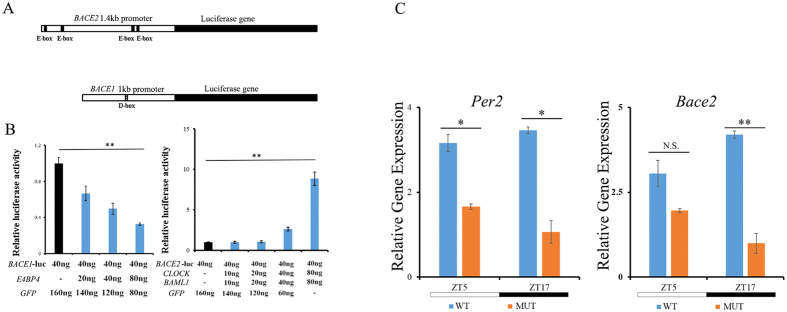
Expression of the BACE genes is controlled by the clock.(A) Schematic plot of the promoters of the BACE genes, including four possible E-boxes located in the 1.4-kb BACE2 promoter and one D-box located in the 1-kb BACE1 promoter. (B) Left pane: transfection of E4BP4 inhibited the transcription of Bace1 in a dose-dependent manner. Right pane: The CLOCK:BMAL1 complex activated the expression of Bace2 in a dose-dependent manner. (C) The expression of Per2 and Bace2 between Clock mutant and WT mice in hippocampus. Clockdelta19/delta19 and WT mice (n = 3) were sacrificed at ZT5 and ZT7 under the LD condition; the expressions of Per2 and Bace2 were decreased at ZT5 and ZT17 in the Clockdelta19/delta19 mice due to the deficiency of the Clock gene; Bar graph (mean ± s.e.m.) of relative gene expression (n = 3, N.S. P > 0.05; *P < 0.05; **P < 0.01, student’s t-test).